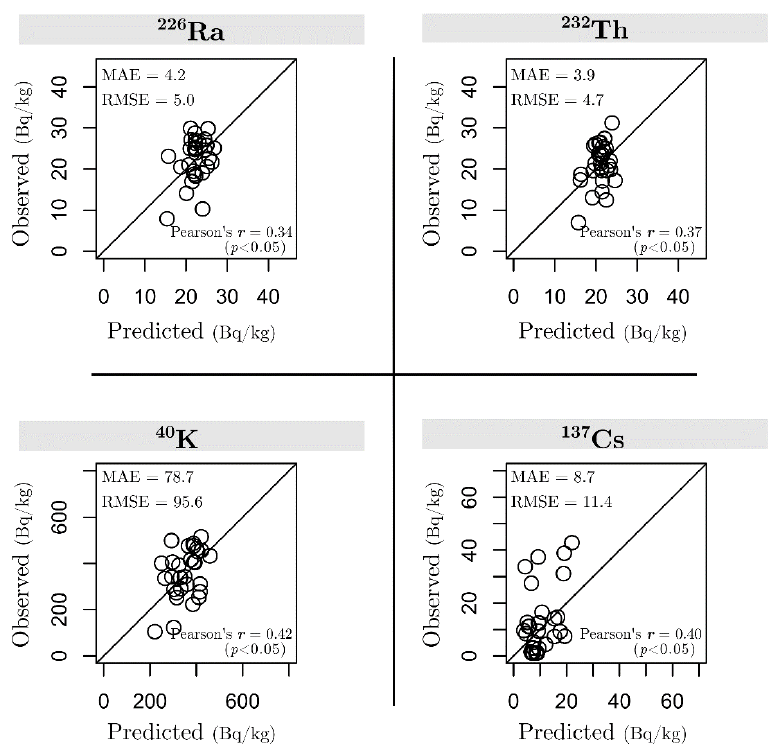
Figure 4. The cross-validation diagrams generated as a result of comparing the predicted values with the observed values for 226 Ra, 232 Th, 40 K, and 137 Cs.